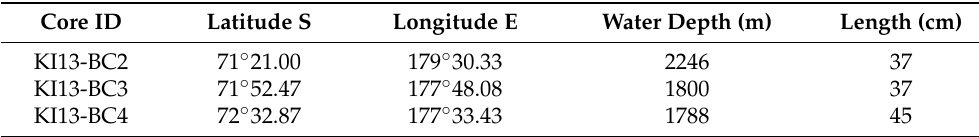
Table 1. List of core locations, core length and water depth. Core